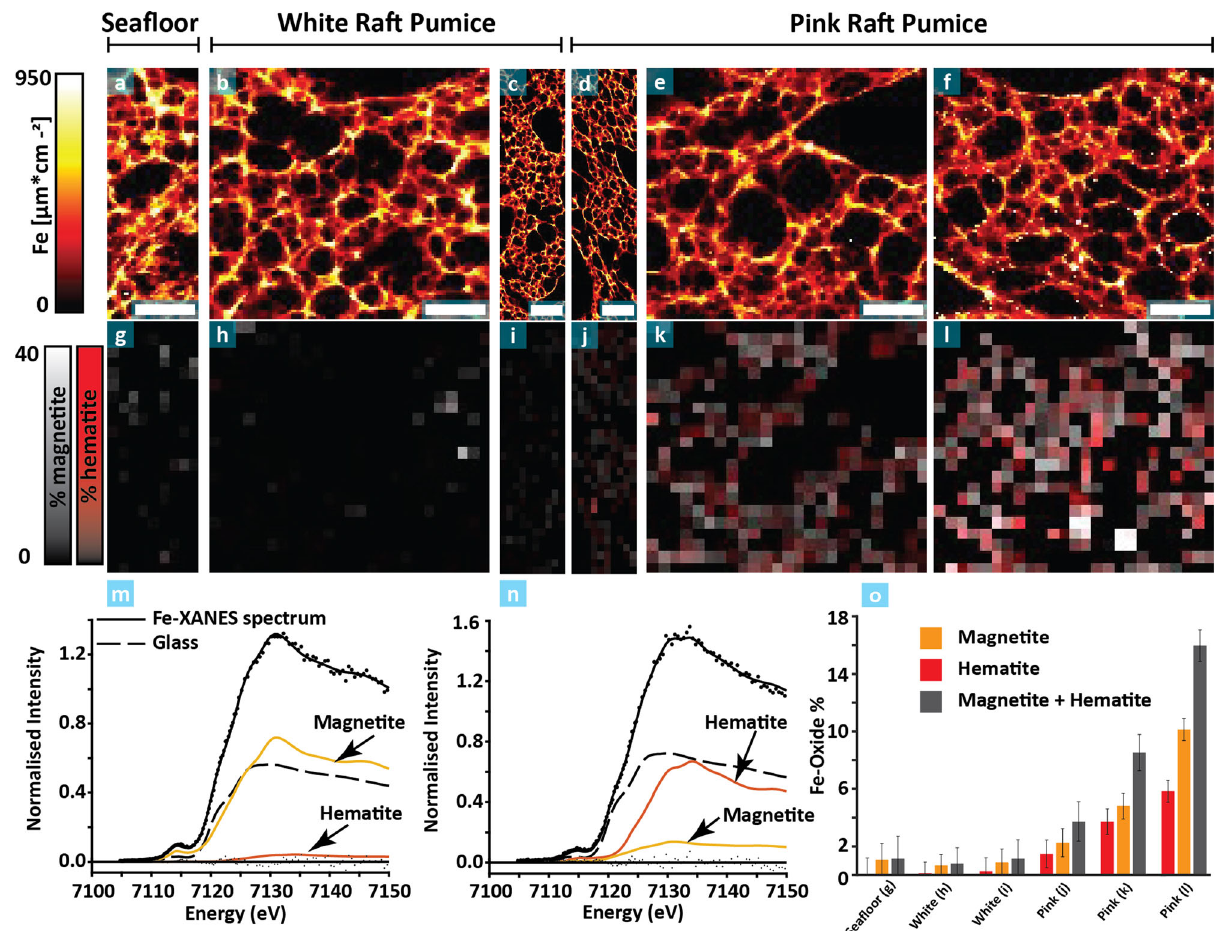
Fig. 5 Fe-XANES maps of the Havre 2012 pumice suite. a – f XFM Fe elemental maps ( µ g*cm − 2 ) where white pixels correspond to areas of high Fe- intensity, indicating magnetite microlites and nanolites. White scale bars are all equal to 100 µ m and scale bars correspond to the panel below each column (e.g., the scale bar in ( a ) corresponds to the scale bar in ( g )). g – l Corresponding Fe-XANES maps presenting the proportion of magnetite (grey scale) and hematite (red scale) merged into one image. m , n Example Fe-XANES spectra of individual pixels results of linear least squares combination fi tting (black solid line) with high proportions of m magnetite and n hematite from within the pink raft pumice Fe-XANES area in 3l. Here we show the spectral contributions from magnetite (yellow solid line), hematite (red solid line), and glass (dashed black line) which combined equal the sum-spectrum data ( fi lled black circles). Residuals in the fi t (black dots) are shown with a line at zero intensity to guide the eye. Additional spectra from all samples are shown in Supplementary Fig. S8. o Percentage of Fe as hematite (red) and magnetite (yellow) in each Fe-XANES analysis area. Percentages are calculated by averaging the portion of magnetite and hematite in every pixel of an Fe-XANES area determined by fi tting every pixel as shown in ( m ). The error was calculated as the mean of the normalized sum of the residuals from the linear combination fi tting. Samples: a , g white sea fl oor pumice (same as in Fig.1a, e), b , c , h , i two different white raft pumice samples ( b , c are the same white pumice in Fig. 1a, e), d – f , j – l ) 3 pink raft pumice samples with different intensities of colouration: d , j tan-brown, e , k orange-pink (Fig. 1c, g), f , l red-pink pumice (Fig. 1d,